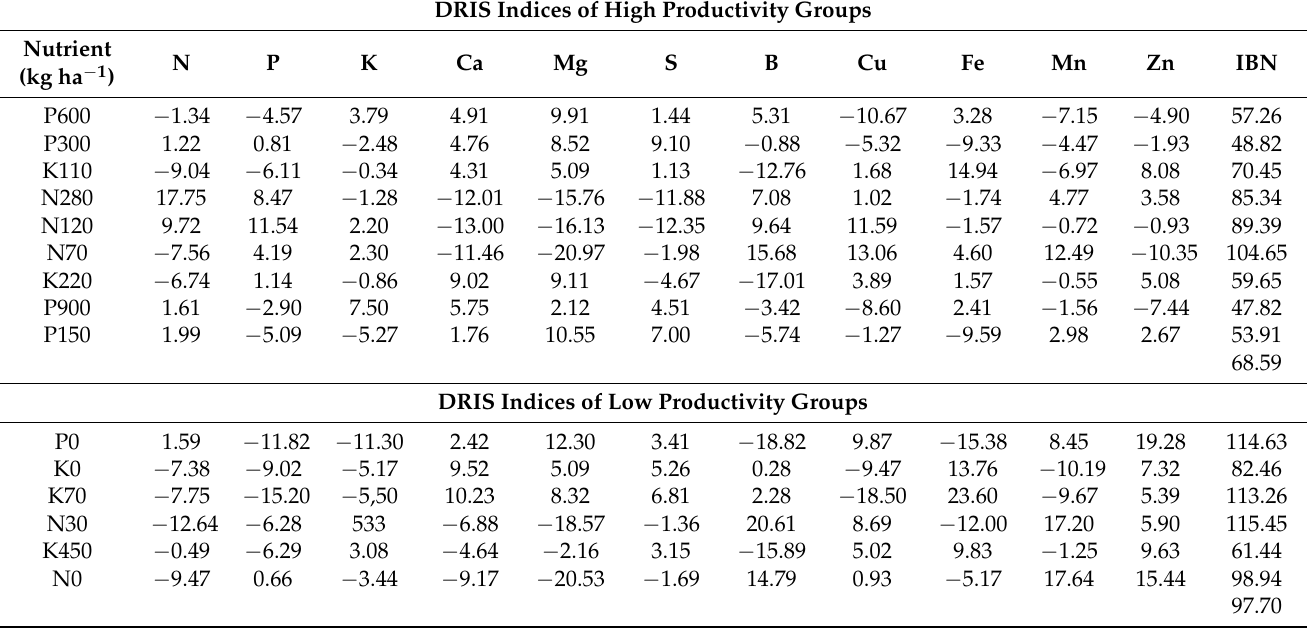
Table 4. DRIS indices for macronutrients and micronutrients in high (>53 t ha − 1 ) and low (<53 t ha − 1 ) productivity potato crops, for the Agata cultivar in Mucug ê